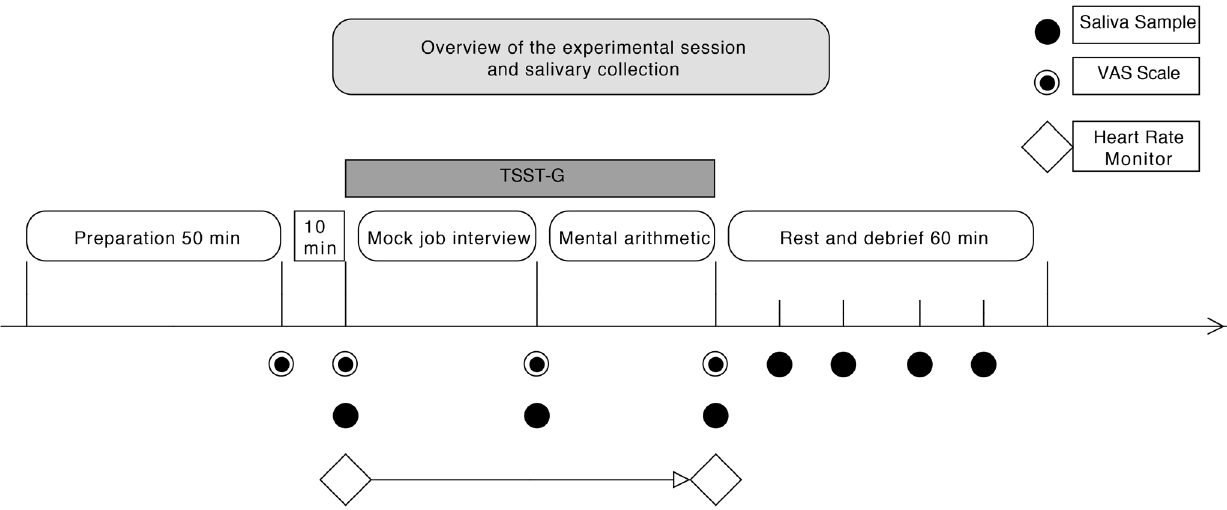
Figure 1. Overview of the exposure session showing collection of saliva samples, VAS scales and heart rate monitoring.